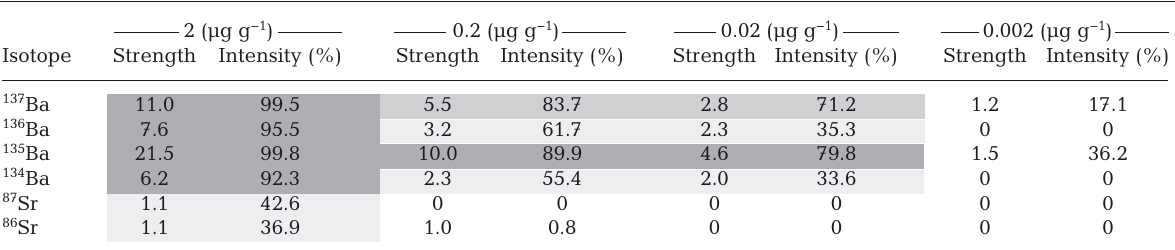
Table 3. Comparison of isotope mark strength and intensity. Strength is the number of times the maximum isotope ratio meas- ured in a marked otolith is greater than the threshold limit. Intensity is the percentage of the otolith marked with an isotope ratio greater than the threshold limit. Shading indicates the minimum number of weeks required between injection date and spawning date to reach 100% marking success for each isotope (dark grey: 1 wk, medium grey: 2 wk; light grey: 3 wk; no shading: 100% marking success was not